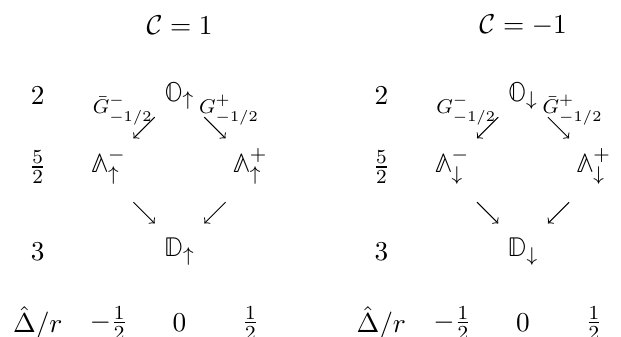
Figure 1 . The supermultiplets containing the displacement operator, and the operators appearing from the breaking of su (2) R and supersymmetry. Both supermultiplets are short, with the one on the left being ( a; c ) and the one on the right ( c; a